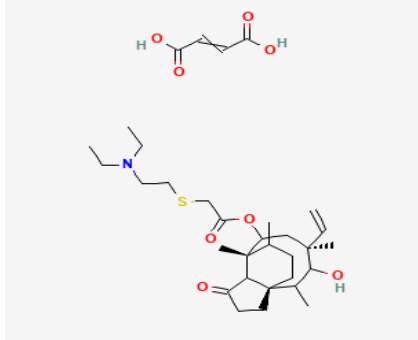
Figure 1. Structure of tiamulin hydrogen fumarate (adapted from [2]).